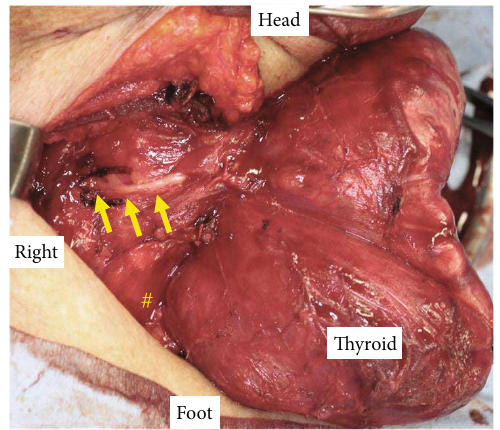
Figure 2: Intraoperative photographs. Nonrecurrent laryngeal nerve (arrows) branching directly from the vagus nerve. # Cervical